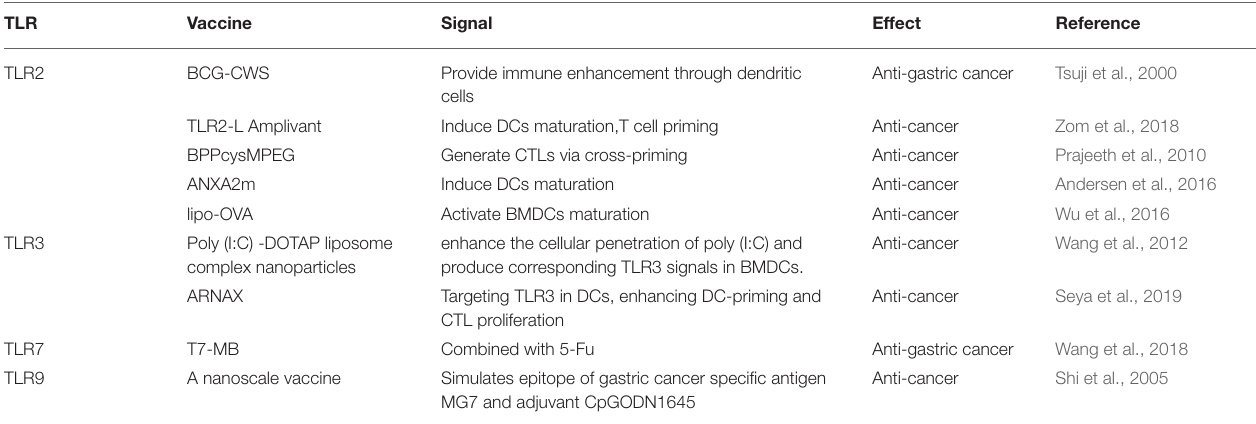
TABLE 2 | The adjuvants of TLRs in the immunotherapy of gastric cancer.